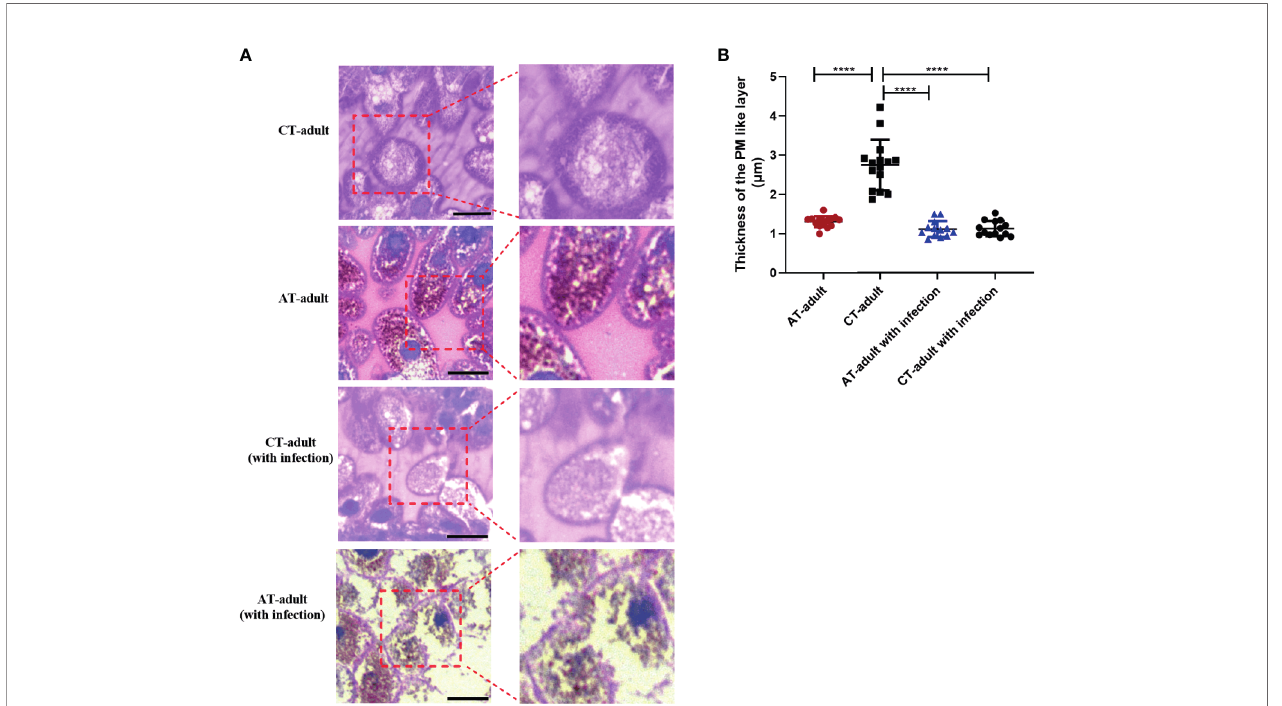
FIGURE 4 | Tick microbiota dysbiosis impairs gut barrier integrity. (A) PAS stain and sectioned 48 h fed guts of AT adults and CT adults (under negative and positive mode). Boxed outlines within the images on the left have been magni fi ed. The scale bar represents 50 m m. (B) Quanti fi cation of relative thickness of the PM- like layer of among different groups. **** means p < 0.0001.